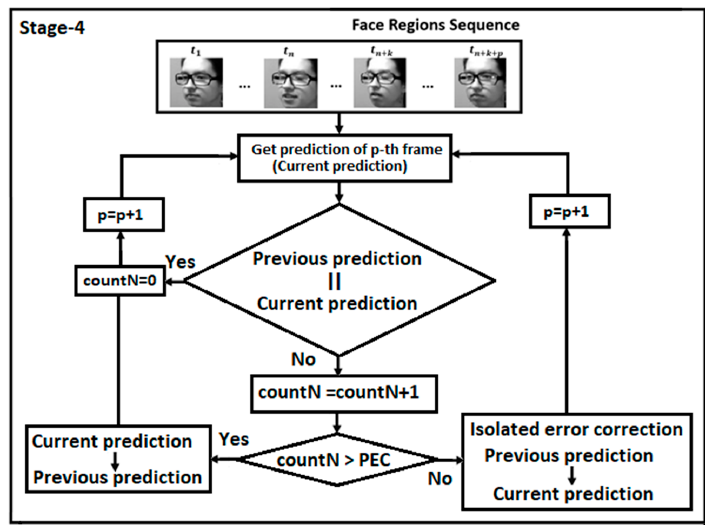
Figure 14. Process for correcting isolated prediction error, caused by the S ‐ CNN.